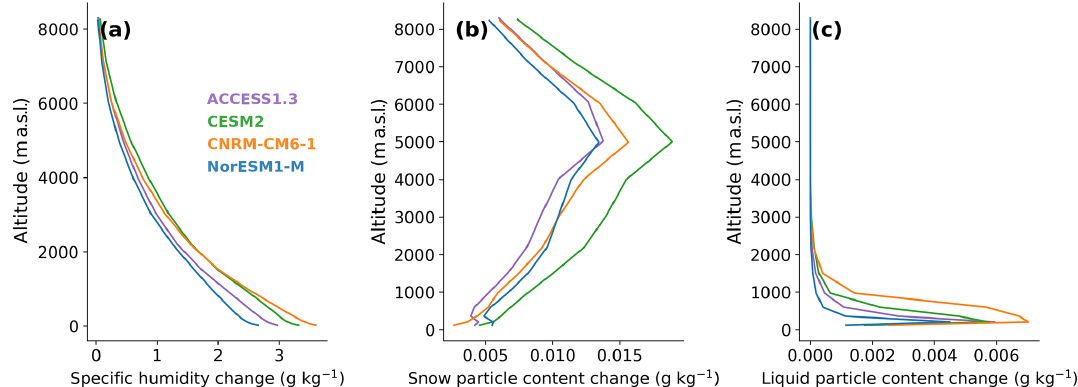
Figure 8. Changes in mean summer vertical specific humidity profiles over the boundaries (a) , snow particle content (b) , and water droplet particle content (c) (gkg − 1 ) over the ice shelves in 2071–2100 compared to 1981–2010 projected by ACCESS1.3 (purple), CESM2 (green), CNRM-CM6-1 (orange), and NorESM1-M